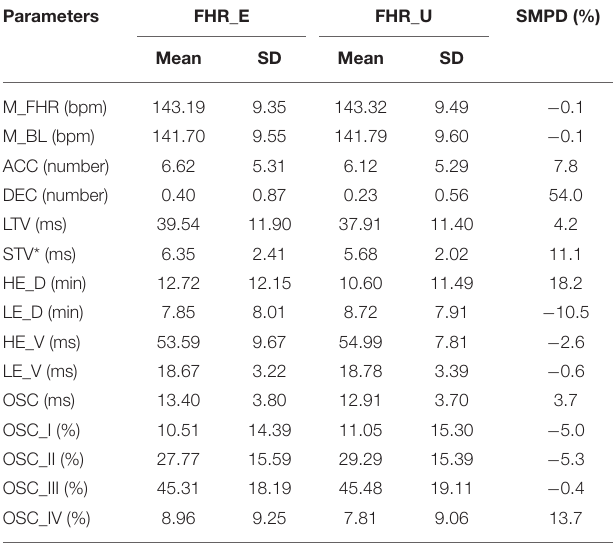
TABLE 2 | Values of clinically important parameters of quantitative description of FHR-E and FHR-U signals, from FECG and US, obtained in a computer-aided fetal monitoring system, together with the symmetric mean percentage difference SMPD estimating the inconsistencies between both the